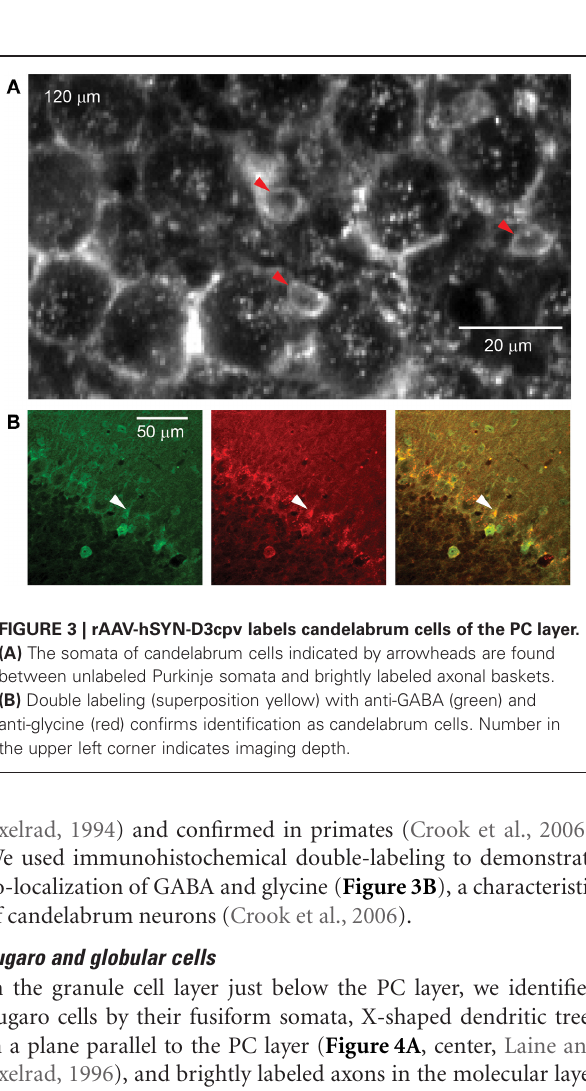
Axelrad, 1994) and confirmed in primates (Crook et al.,